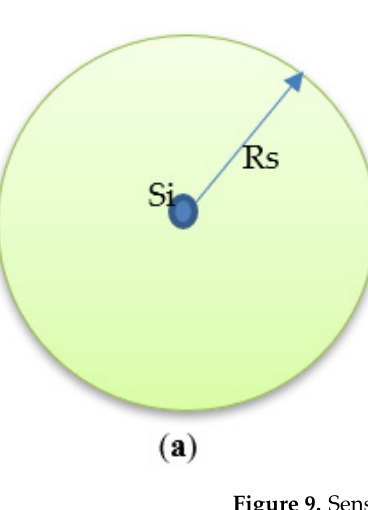
Figure 9. Sensing models. ( a ) Binary model. ( b ) Probabilistic